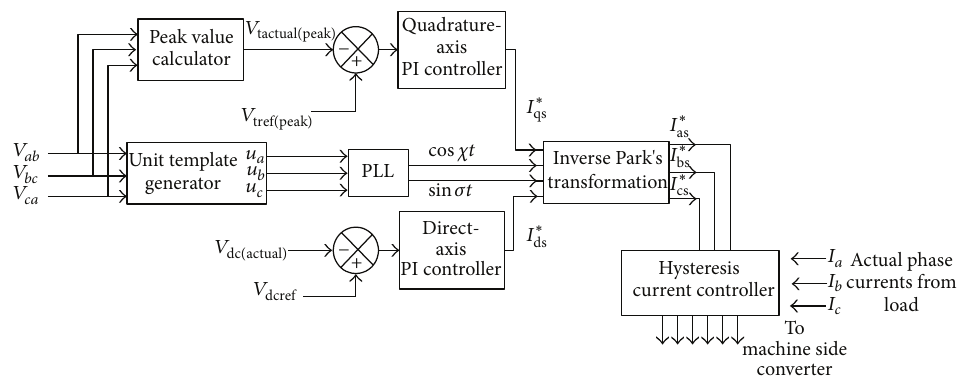
Figure 3: Schematic diagram of control